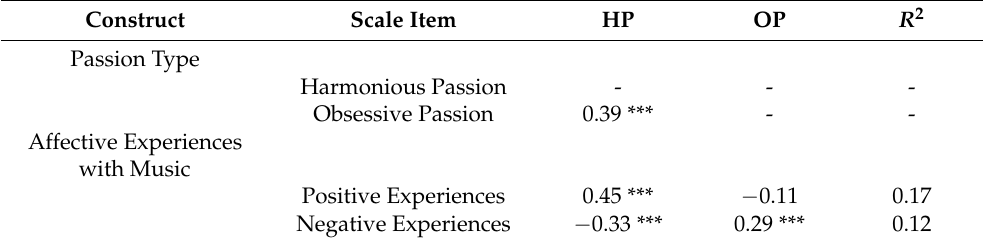
Table 3. Harmonious Passion and Obsessive Passion as Predictors of Experiences with